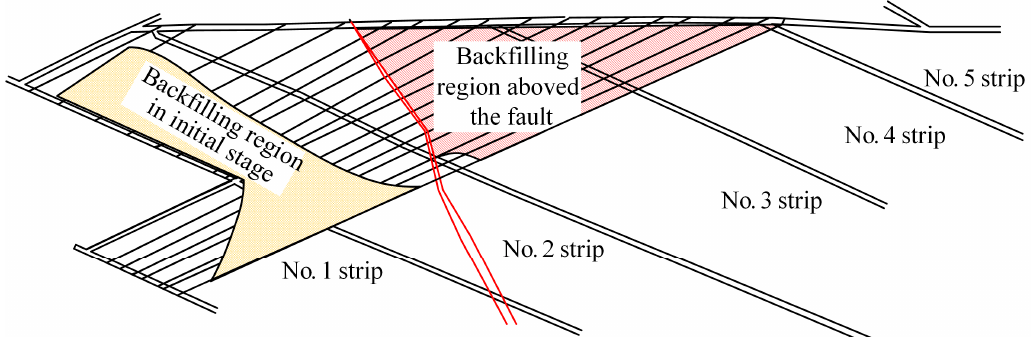
Figure 13. Inferred backfilling form of gangue in the 845 working face. Minerals 2018 , 8 , x FOR PEER REVIEW